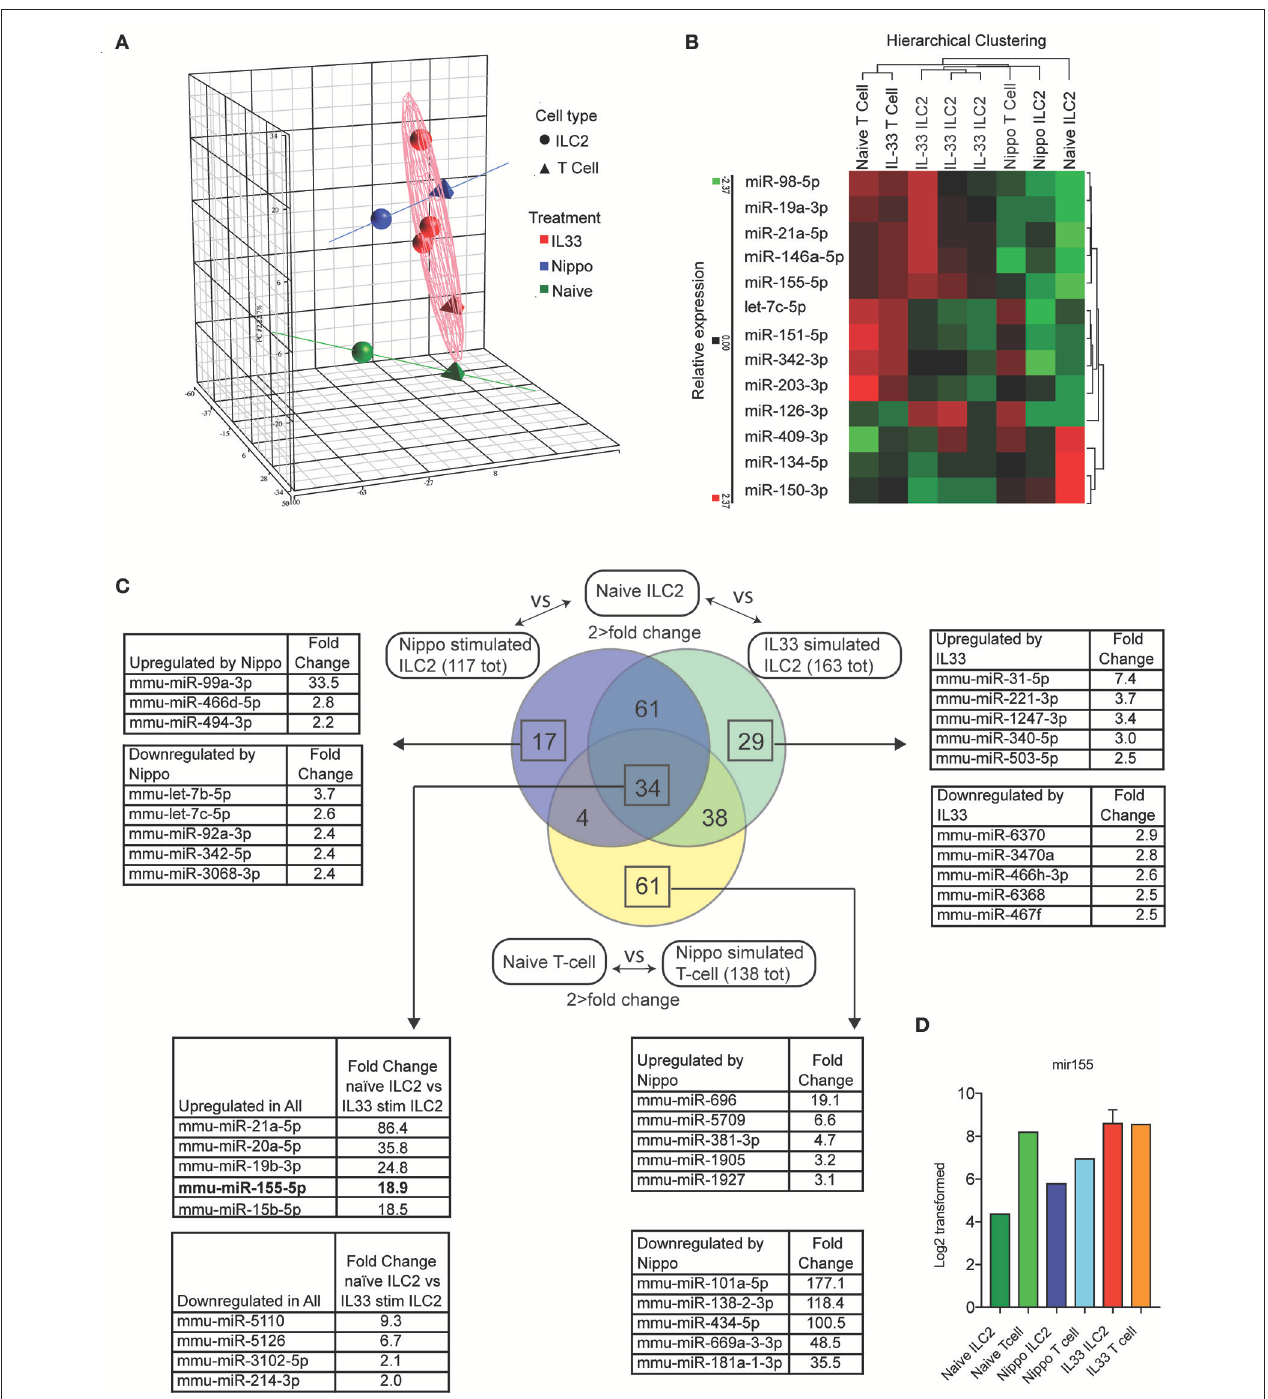
FIGURE 1 | Differential regulation of miRNAs in ILC2 following activation. (A) PCA analysis of microRNA expression by ILC2 from mice stimulated with IL-33 or infected with N. brasiliensis (5 d.p.i,). Tetrahedrons represent T cells, spheres represent ILC2, red for IL-33 stimulation, blue for N. brasiliensis exposure and green for naïve cells. Ellipsoid and colored lines show the relationship between stimulation type and miRNA variation. (B) Relative expression and hierarchical clustering of miRNA known to be involved with leukocyte activity, relative expression is indicated (red, higher; green, lower). (C) Venn diagram of miRNAs that exhibit a > 2-fold change in expression in IL33 or N. brasiliensis stimulated ILC2 compared with naïve ILC2 and similarly for T cells exposed to N. brasiliensis compared with naive T cells. Lists of miRNA with the top 5 greatest fold-change values, both upregulated and downregulated, are shown for the indicated sections where applicable. The list corresponding to the 34 miRNA changed in all 3 populations show the top 5 upregulated and downregulated miRNA in IL33 stimulated compared with naïve ILC2s are shown. (D) MiR155 log2 transformed data are shown for each sample.